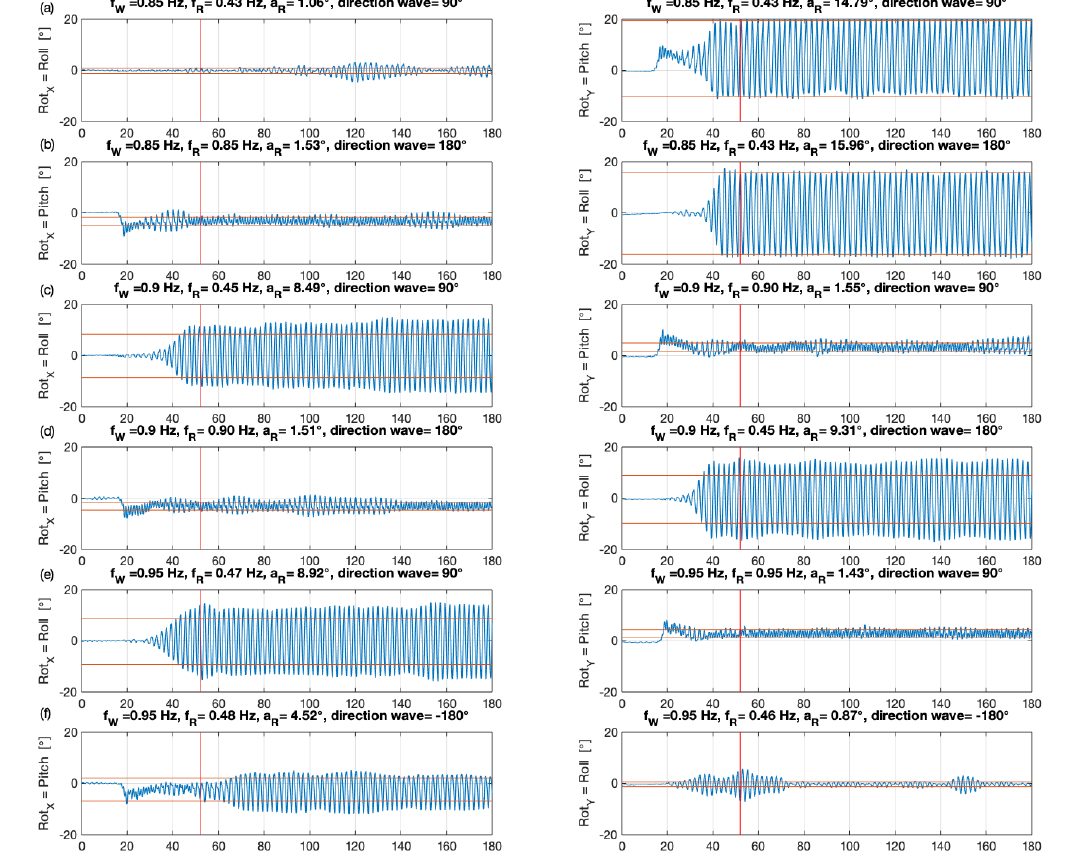
Figure 14. Sample time series of roll and pitch for six test runs with different requested wave frequency f W and comparison of the wave direction of 90 ◦ and 180 ◦ — ( a ) f W = 0.85 Hz, 90 ◦ , ( b ) 0.85 Hz, 180 ◦ , ( c ) 0.90 Hz, 90 ◦ , ( d ) 0.90 Hz, 180 ◦ , ( e ) 0.95 Hz, 90 ◦ , ( f ) 0.95 Hz, − 180 ◦ —vertical red line indicates the 52 s ramp-up time. The horizontal red lines mark the response amplitude ± a R and the connected response frequency f R is provided in the title of the individual